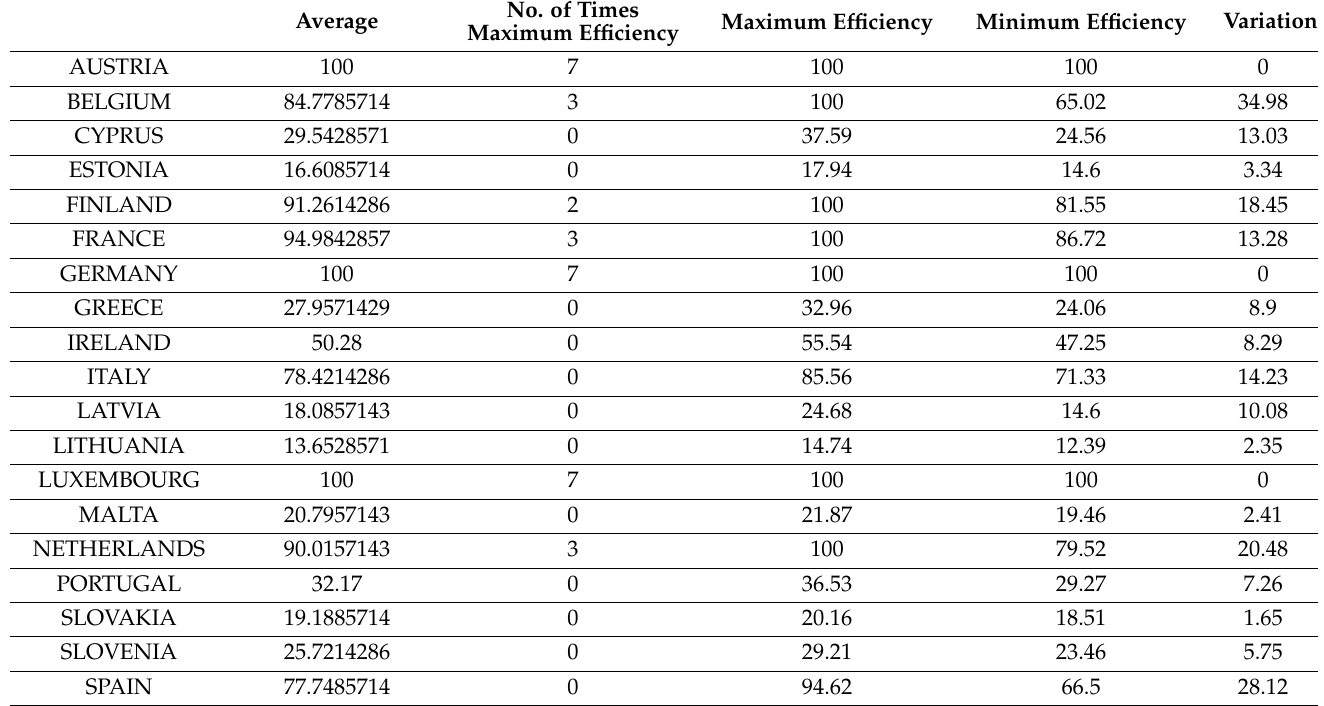
Table 5. Average efficiency of the countries of the Eurozone (2007–2013).